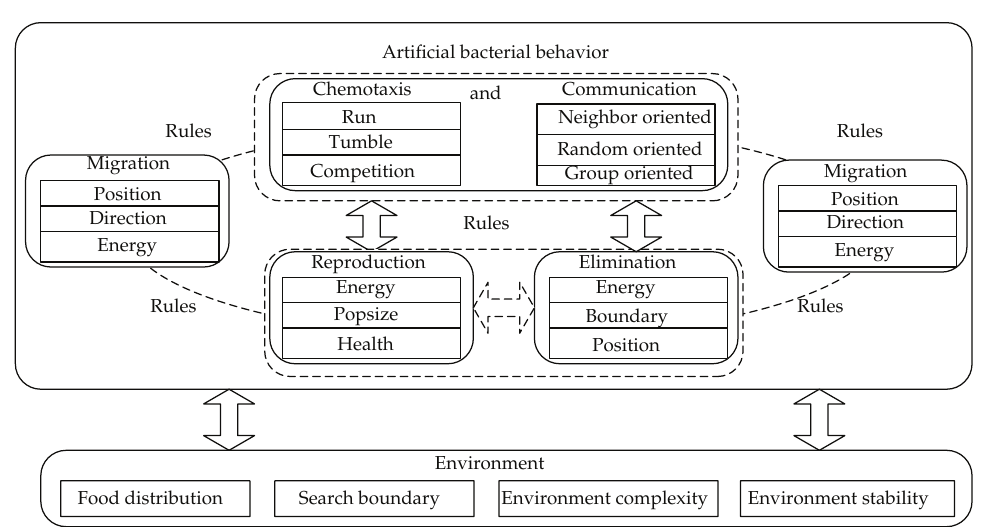
Figure 3: Lifecycle